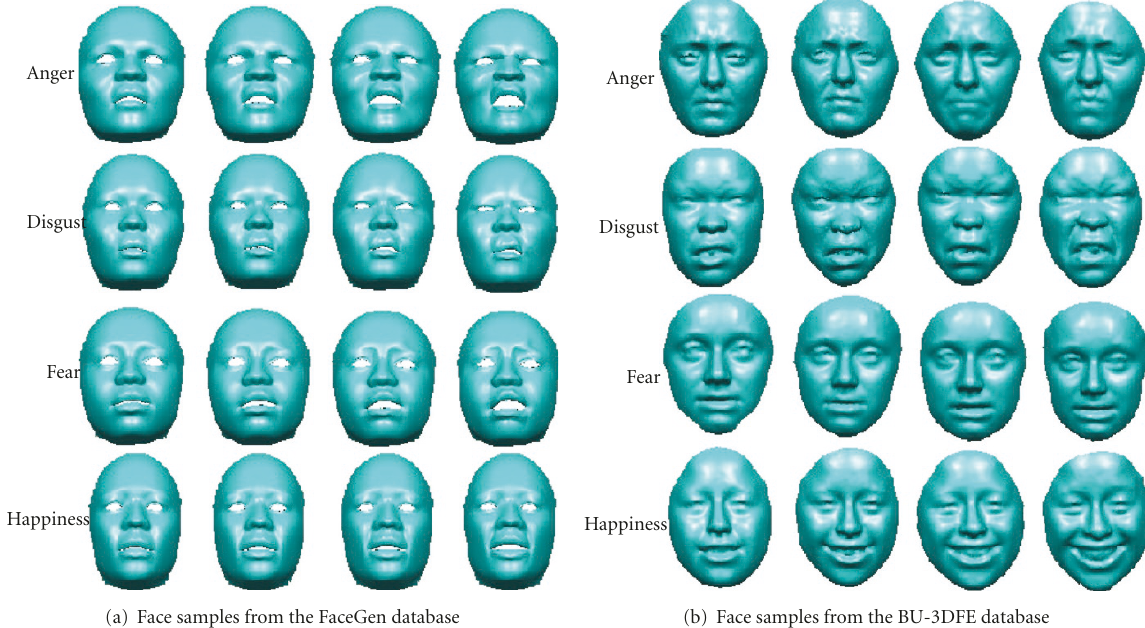
Figure 4: Face samples showing four di ff erent subjects and expressions with four levels of expression intensity.